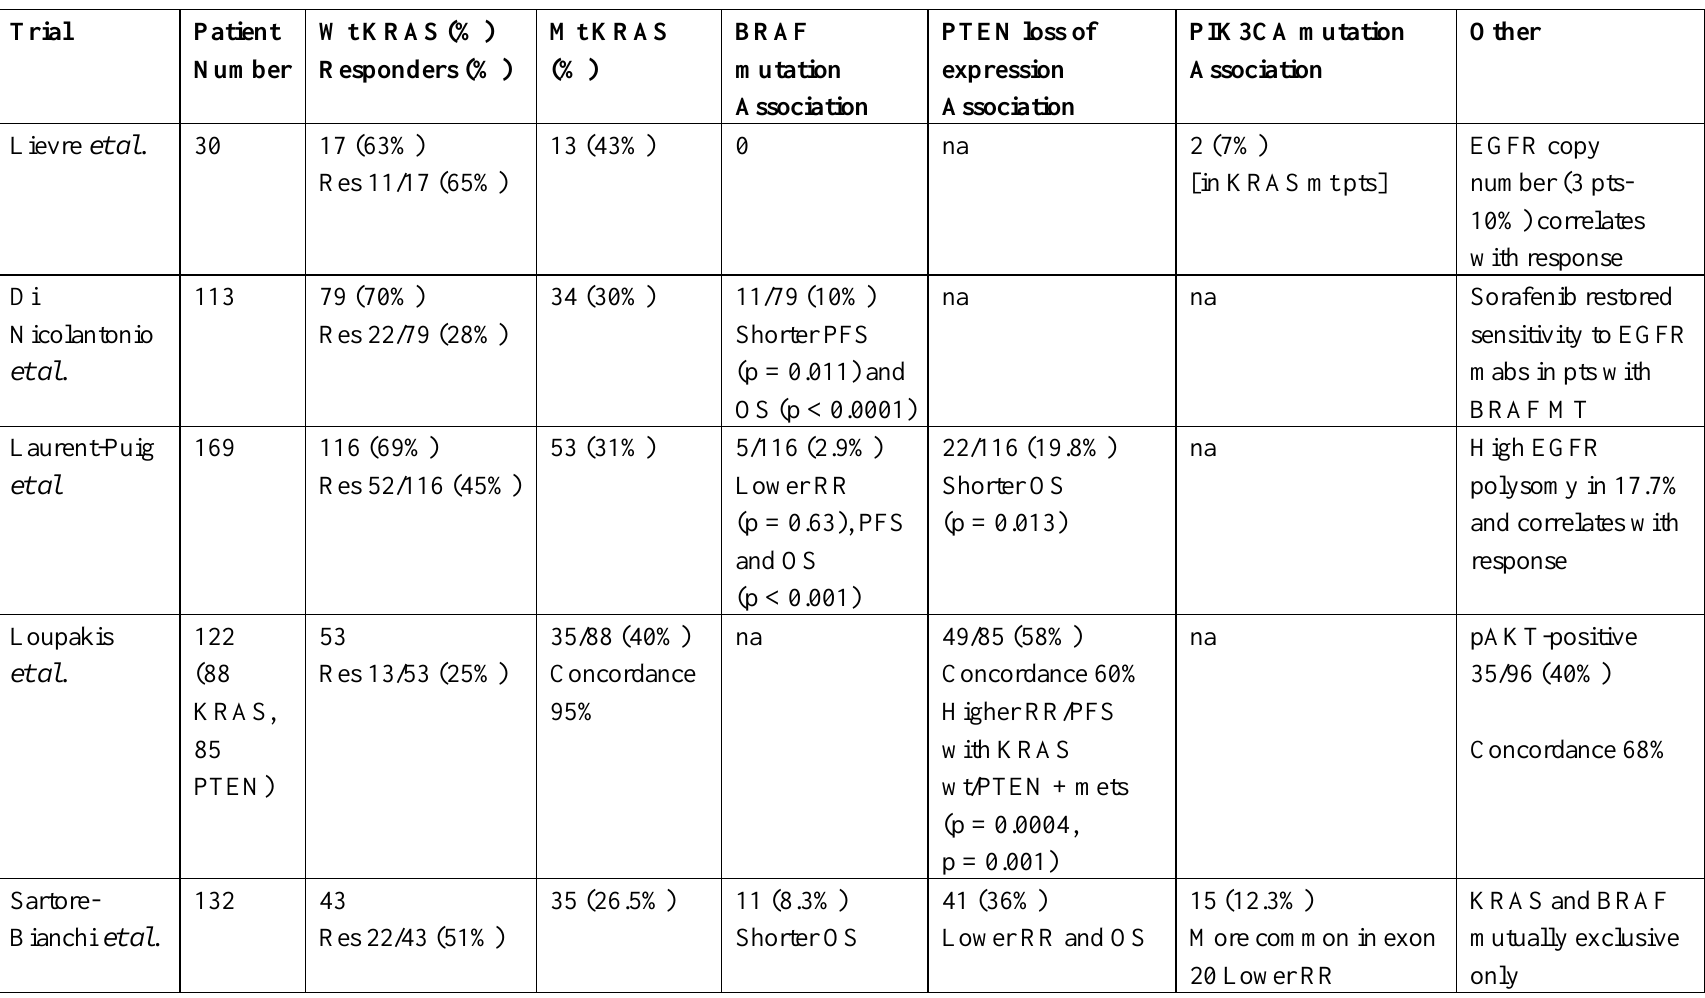
PIK3CA mutation Other expression Association Association